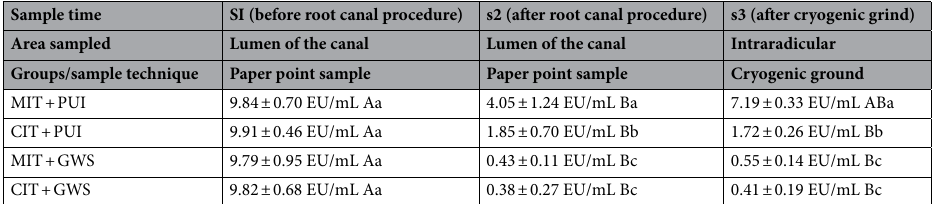
Table 1. Lipopolysaccharides (LPS) content (mean ± SD) found in each group at different sampling times (s1, s2, and s3). Different uppercase letters mean intragroup significant difference (p < 0.05). Different lowercase letters = intergroup significant difference (p < 0.05). MIT Minimally Invasive Instrumentation Technique, CIT Conventional Instrumentation Technique, PUI Passive Ultrasonic Irrigation, GWS GentleWave